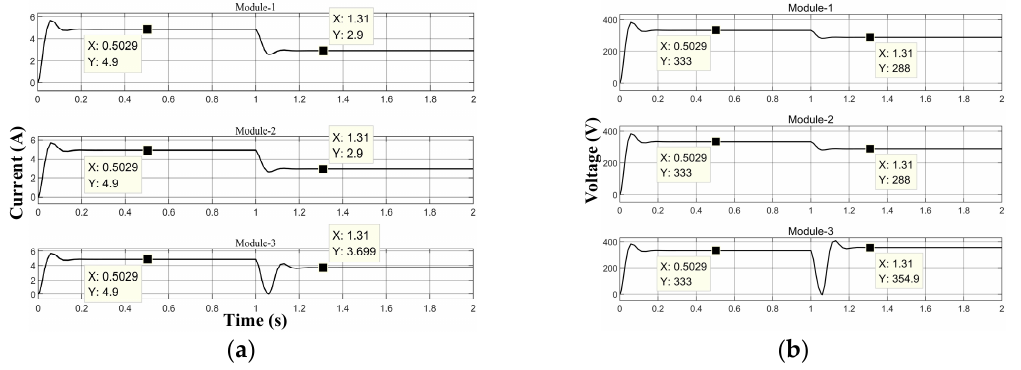
Figure 10. Simulation results of combined converter 1 under condition 2: ( a ) input current of the modules and ( b ) output voltage of the modules.